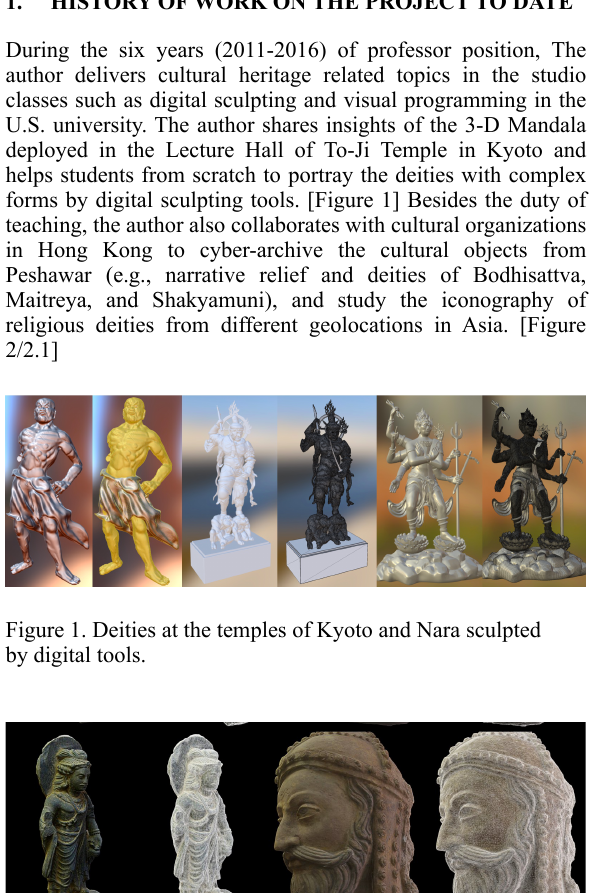
[Figure 4] The Mikaeri Amida (Amitabha Looking Back) deity at Zenrin-Ji in Kyoto for example, “looks back to the sentient beings with mercy, and interprets the attitudes of thinking